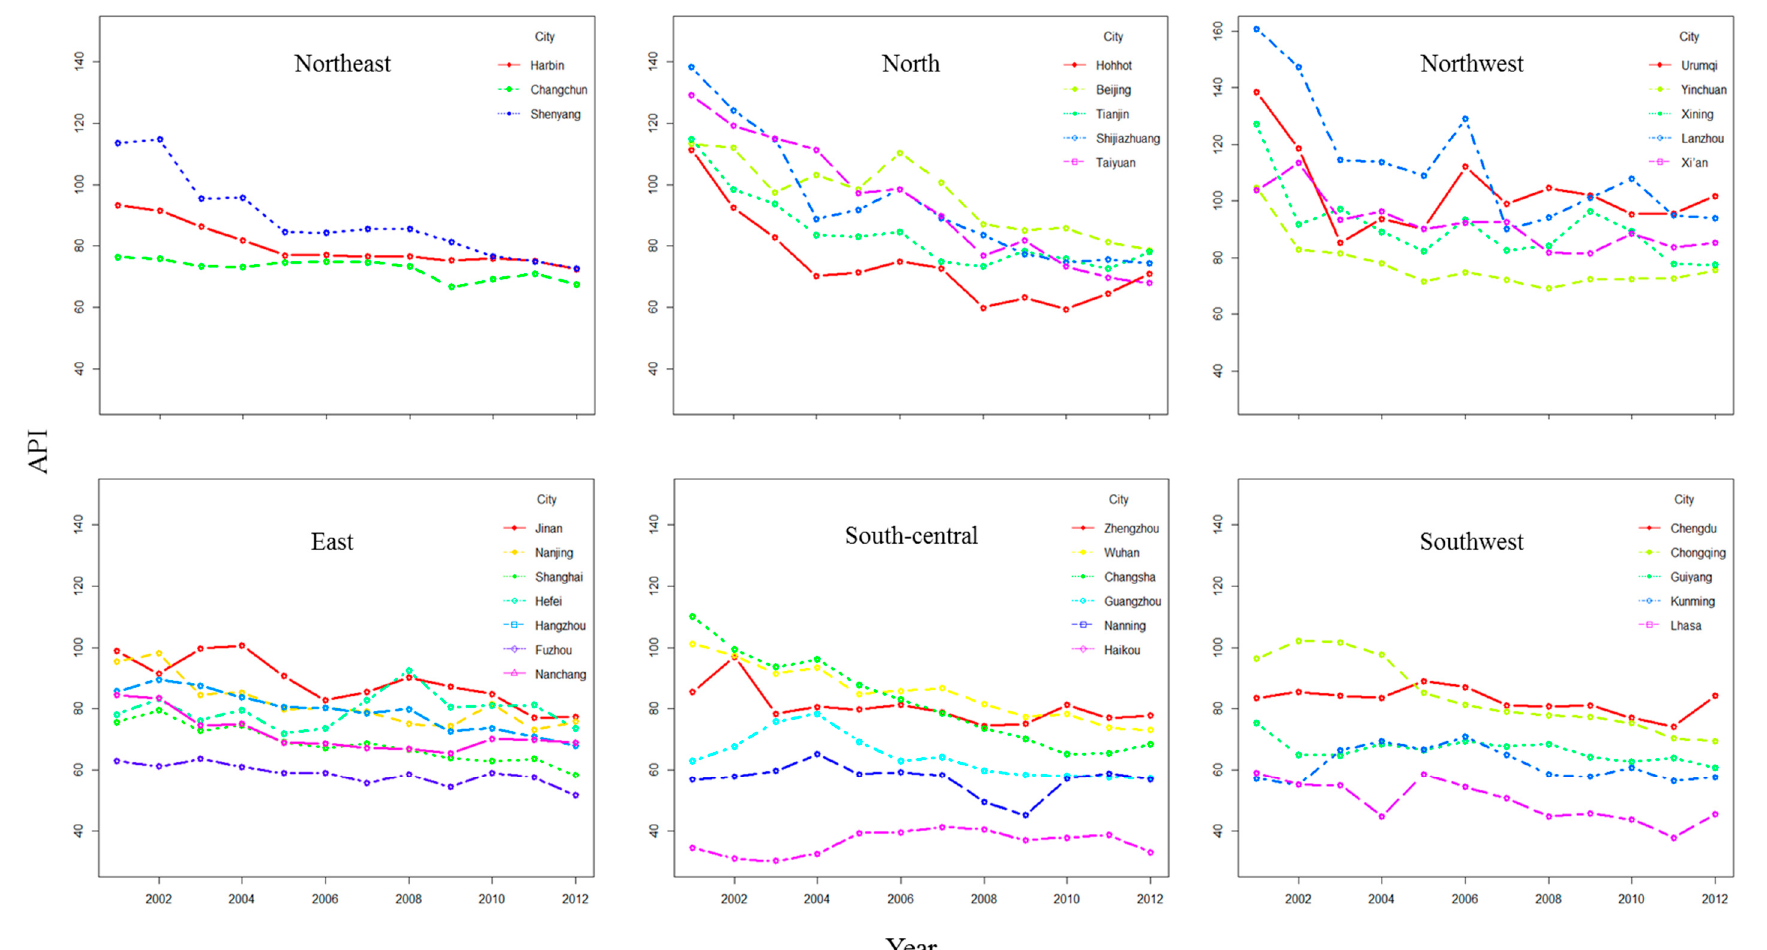
Figure 2. The changing API trends from 2001–2012.